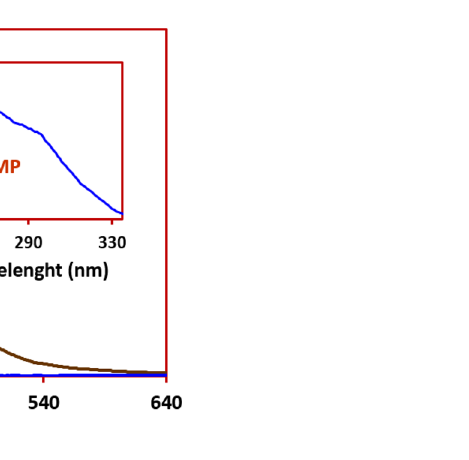
Figure 9. Other mechanisms for the dimerization of IMPH-OH.